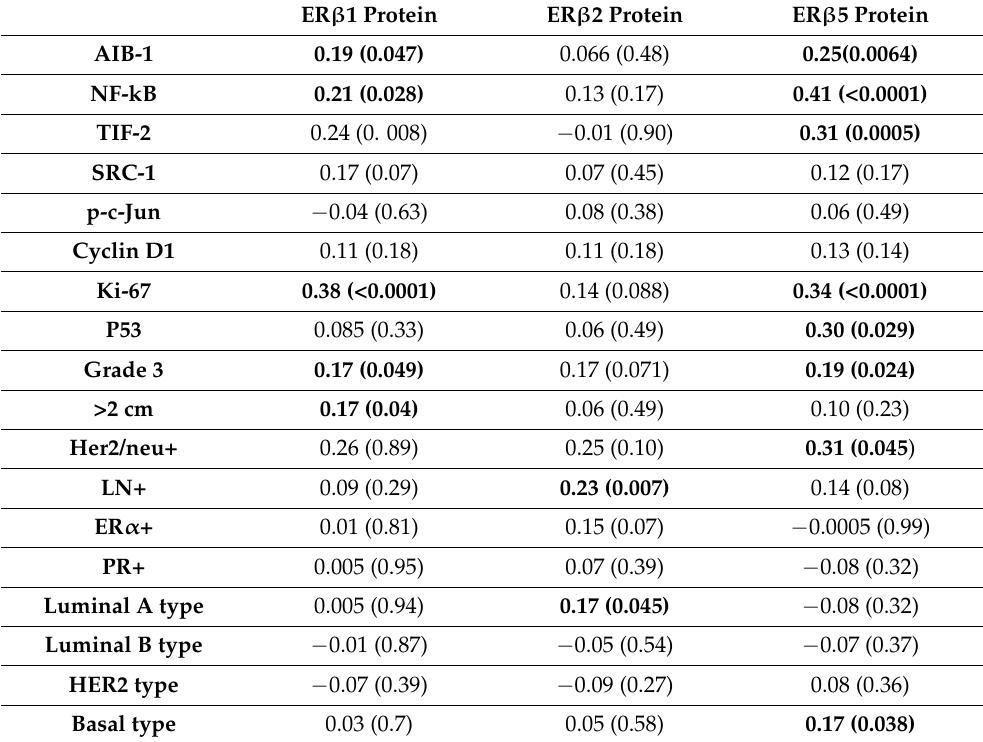
Table 4. Spearman rank correlation of ER β isoform protein expression with coactivators and clinical parameters in the entire